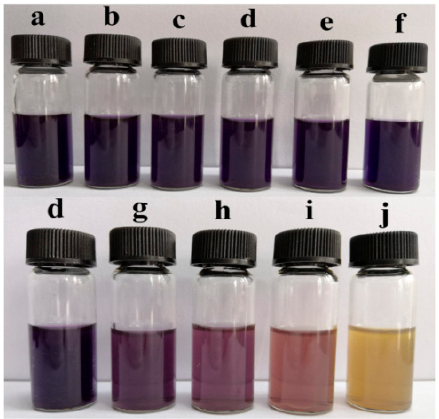
Figure 7. DPPH radical scavenging activity. ( b ) Control film; ( c ) 1% TiO 2 -N; ( d ) 3% TiO 2 -N; ( e ) 5% TiO 2 -N; ( f ) 7% TiO 2 -N; ( g ) 3% CO-3% TiO 2 -N; ( h ) 6% CO-3% TiO 2 -N; ( i ) 9% CO-3% TiO 2 -N; and ( j ) 12% CO-3% TiO 2 -N.